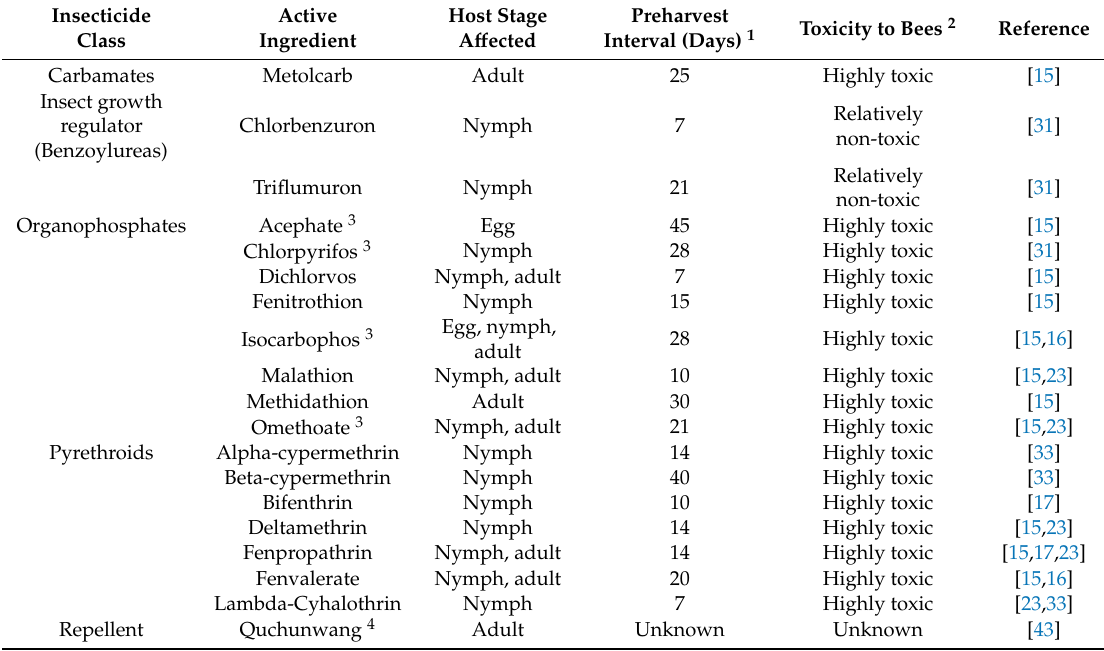
Table 4. List of insecticides used against Erthesina fullo in